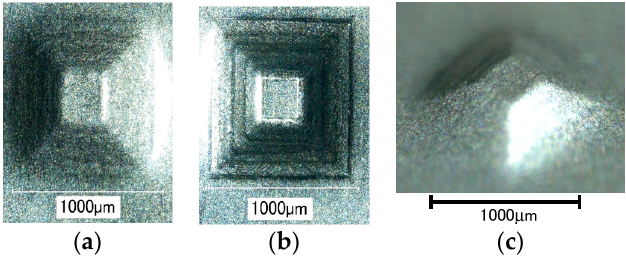
Figure 15. Titanium pyramids of D = 1.41 mm formed without ultrasonic vibration: ( a ) top view; ( b ) bottom view; ( c ) high angle view.